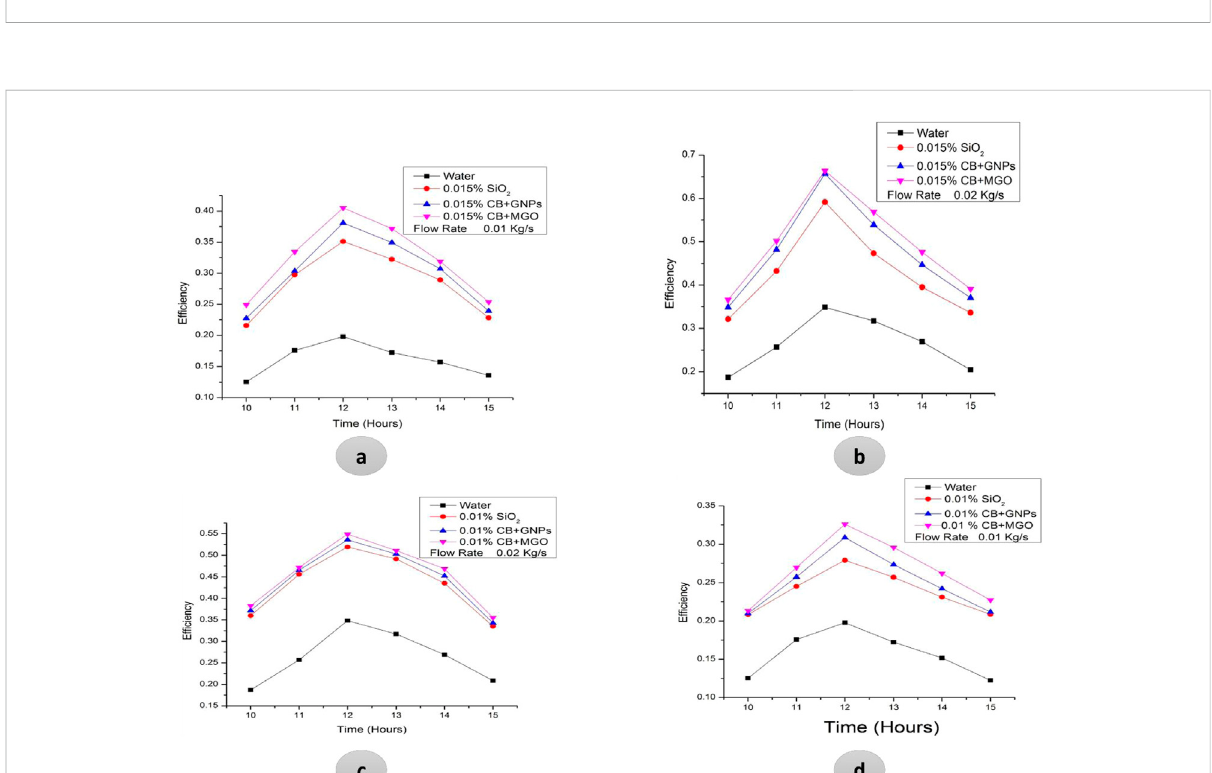
FIGURE 10 Ef fi ciency at different fl ow rates with different concentrations of NFs and hybrid NFs. (A) 0.01 kg/s, with 0.015 wt% concentration of NFs and hybrid NFs. (B) 0.020 kg/s, with 0.015 wt% concentration of NFs and hybrid NFs. (C) for 0.020 kg/s and 0.010 wt% concentration of NFs and